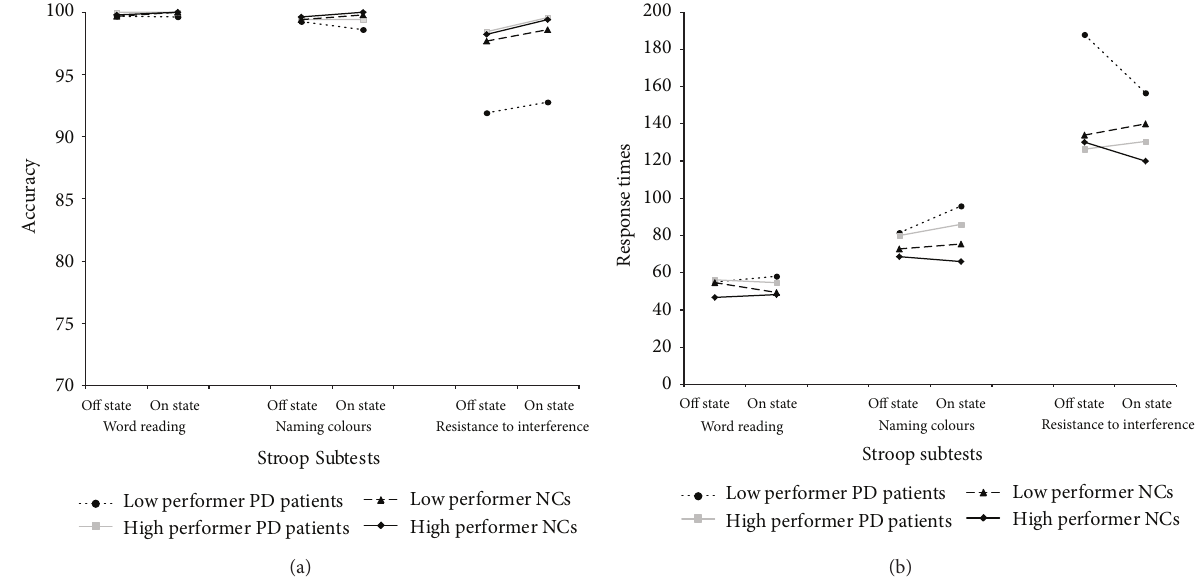
Figure 1: Average performance on Stroop subtests of individuals in the four experimental groups. Accuracy (a) and response times (b) are reported.